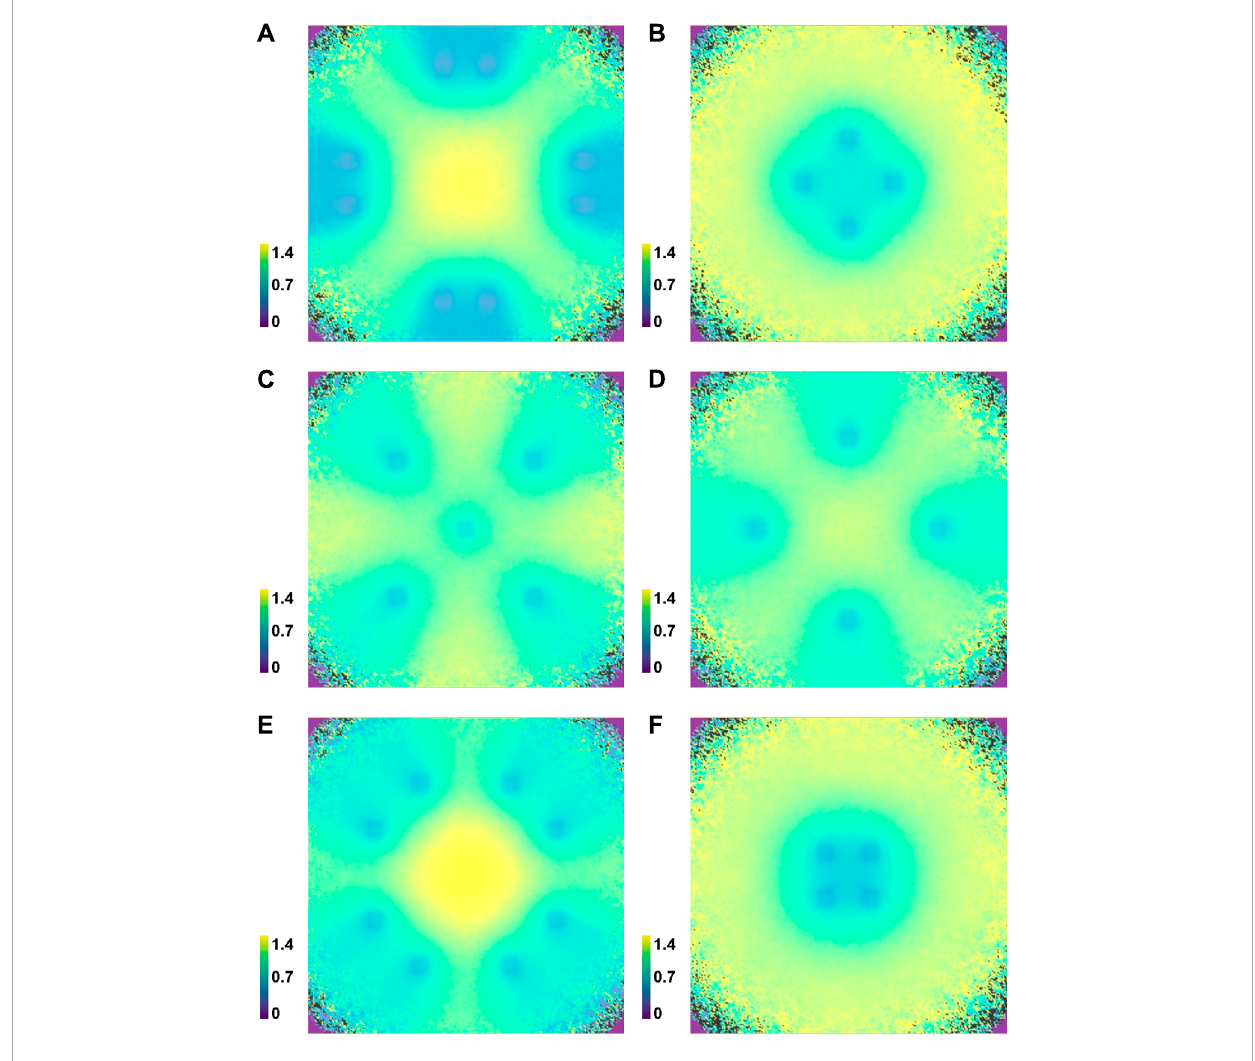
FIGURE 10 Neutron flux distribution in xy plane approximately in the middle of active core height, relative to the ARO (All Rods Out) core configuration, calculated using MCNP core model for individual control rod completely inserted. Normalized neutron flux values are represented with colors, ranging from low values in blue to high values in yellow. (A) A bank. (B) B bank. (C) C bank. (D) D bank. (E) SA bank. (F) SB